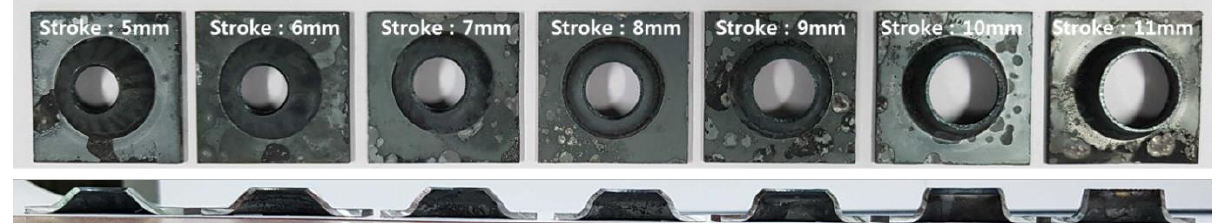
Figure 7. Change in material thickness according to stroke; ( a ) stroke 5 mm; ( b ) stroke 6 mm; ( c ) stroke 7 mm; ( d ) stroke 8 mm; ( e ) stroke 9 mm; ( f ) stroke 10 mm; ( g ) stroke 11 mm.